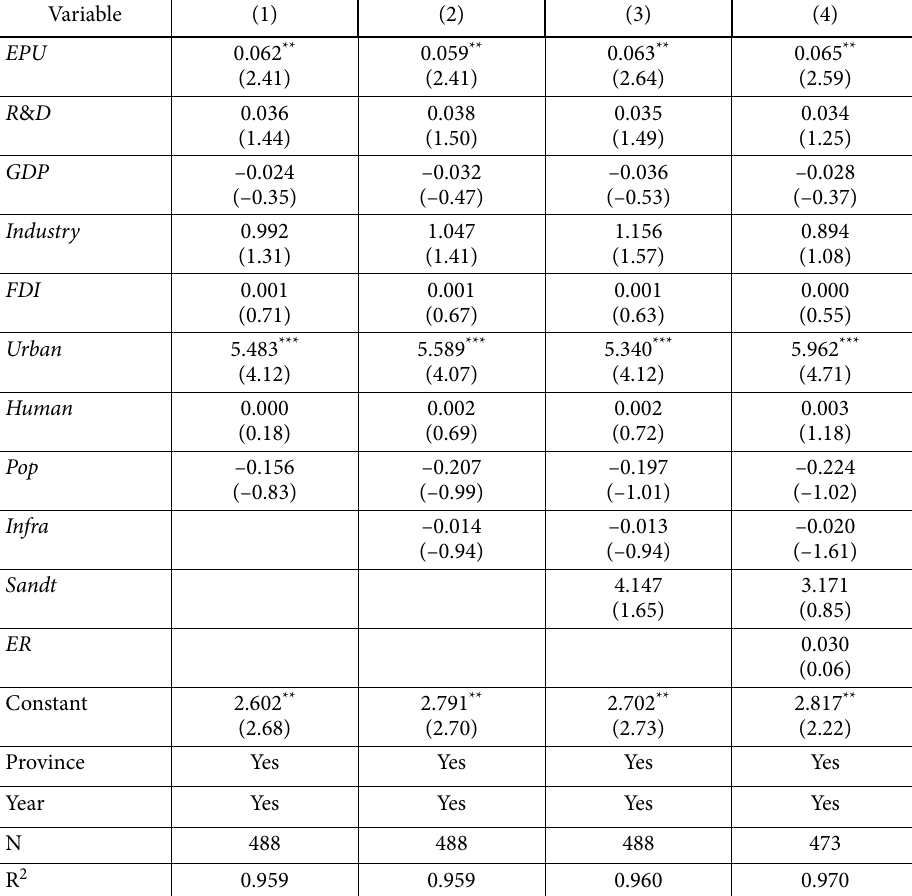
Table 8. Robustness tests: add omitted